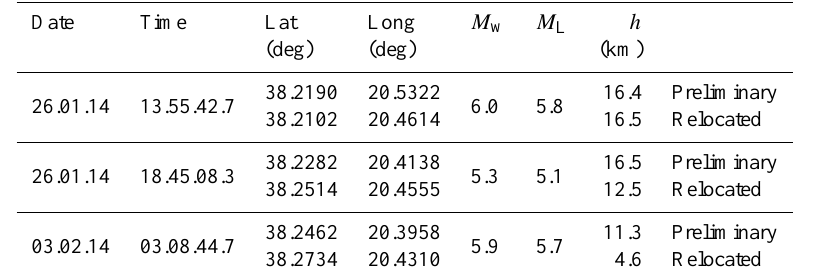
Table 1. Focal parameters of the three strong earthquakes of the January–February 2014 Cephalonia seismic sequence as preliminary calcu- lated by NOA. The revised solutions are also shown.